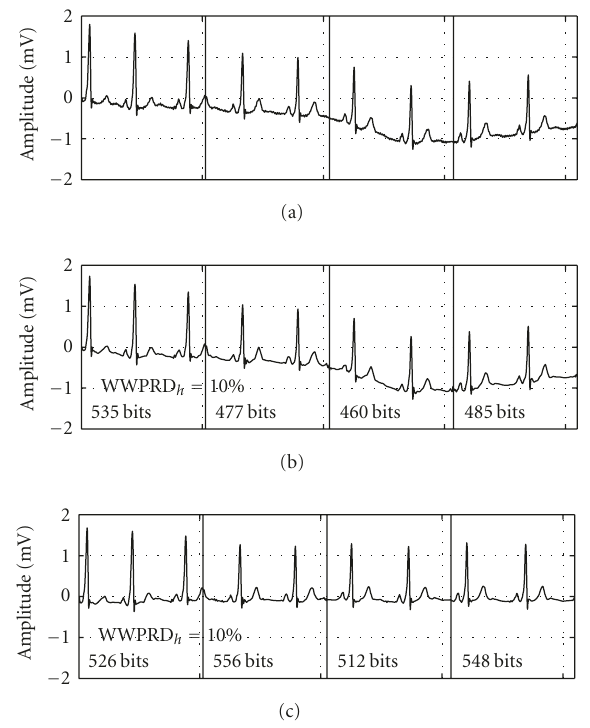
Figure 2: E ff ects on compression quality due to baseline wander- ing. (a) Original signal. (b) Reconstructed signal with baseline wan- dering. Target WWPRD h = 10%. (c) Reconstructed signal without baseline wandering. Target WWPRD h =